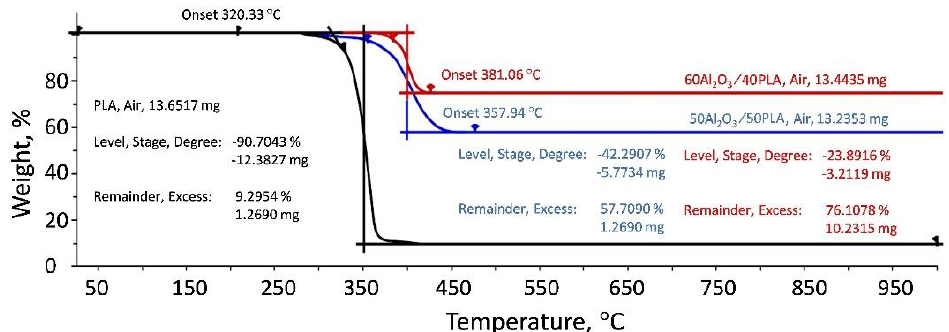
Figure 13. TGA curves of PLA, 50Al 2 O 3 /50PLA and 60Al 2 O 3 /40PLA compositions.